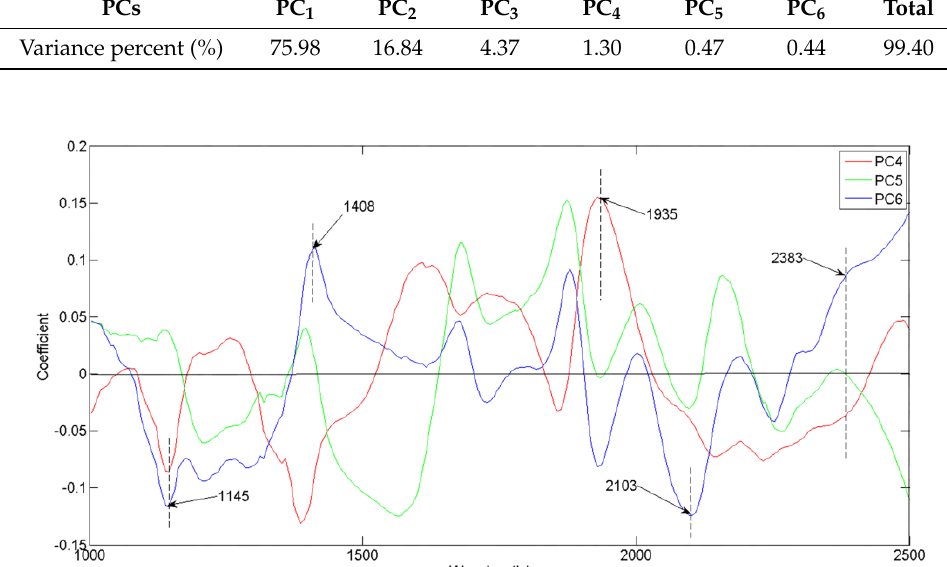
Table 5. Variance percentages of the first six PCs.